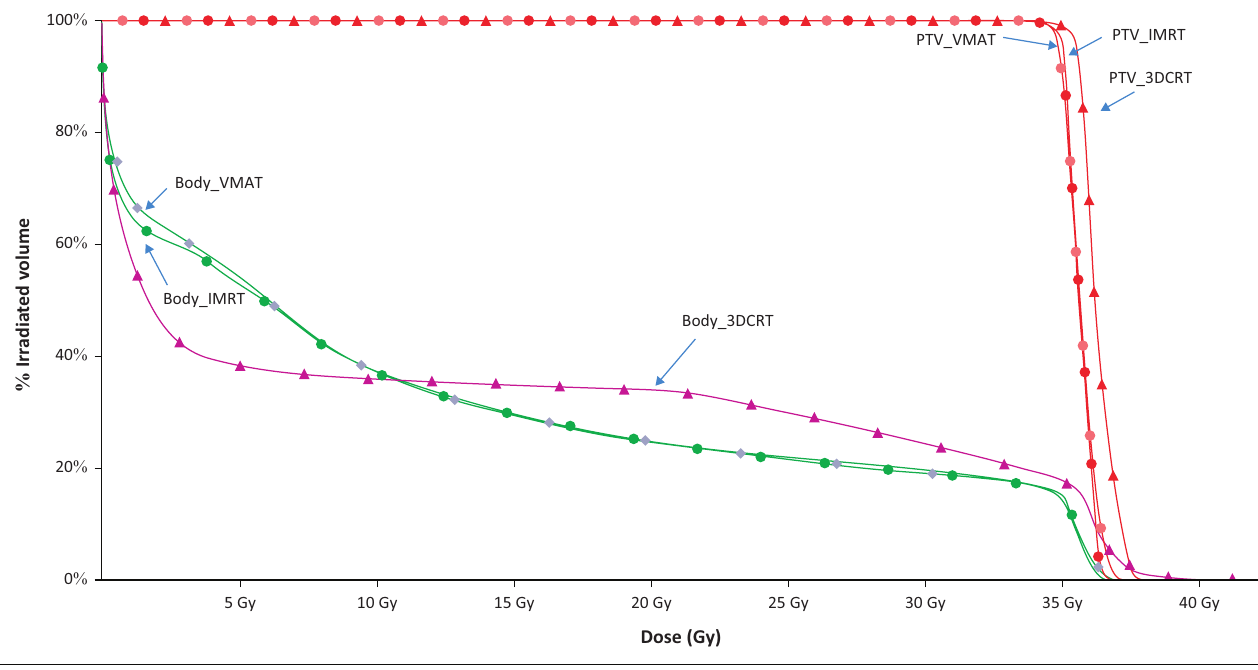
FIGURE 2: Dose-volume histograms of planned target volumes and total irradiated body for one